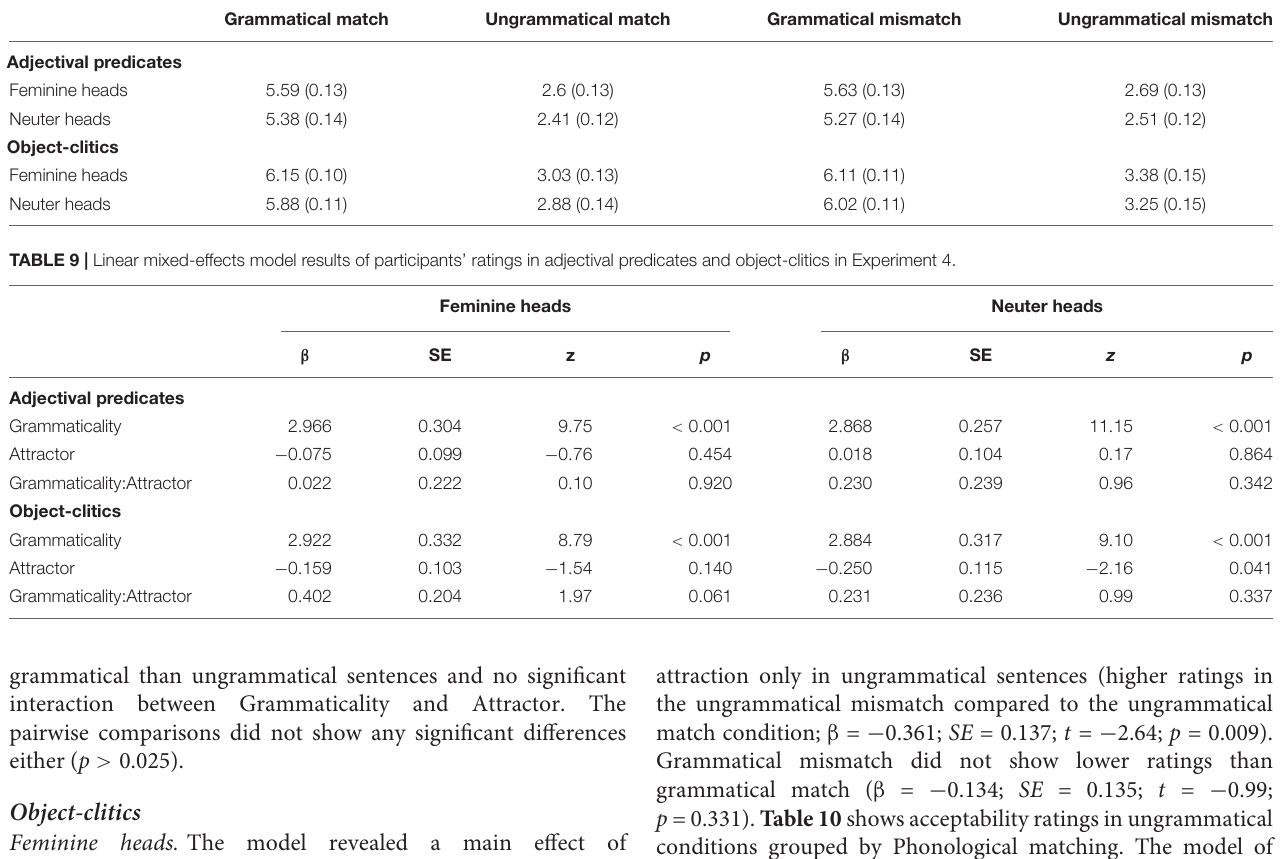
TABLE 8 | Participants’ mean ratings and standard error in adjectival predicates and object-clitics in Experiment 4.